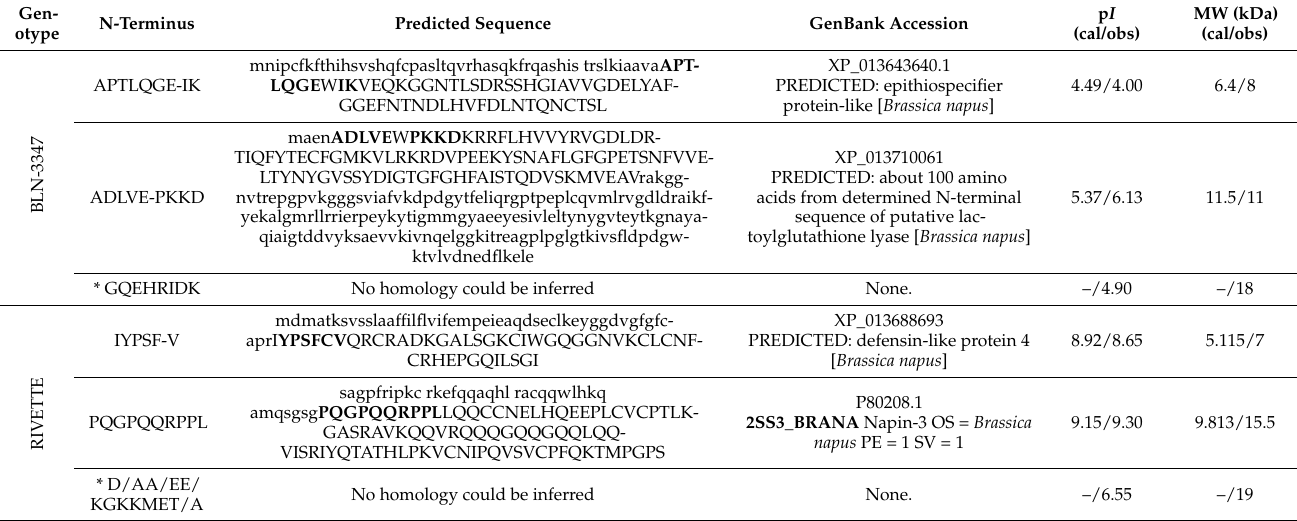
Table 2. Identification and comparison of the amino acid sequences of protease inhibitors from two canola genotypes. Gen-